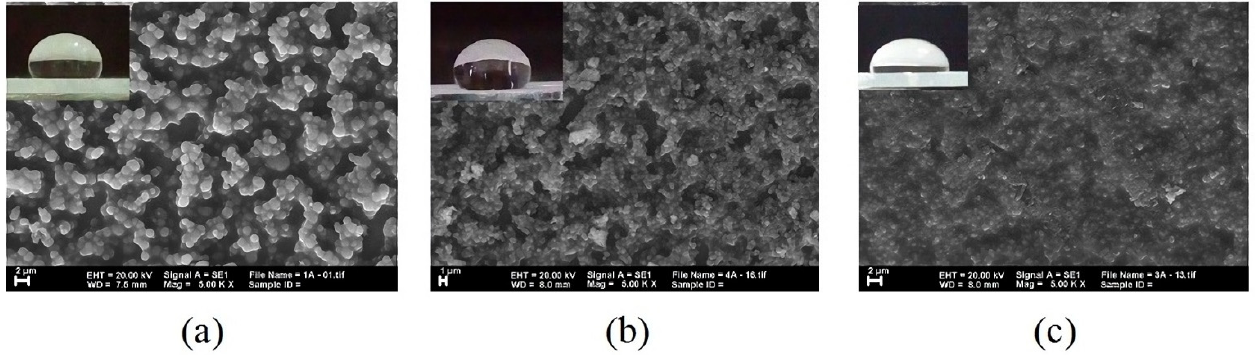
Figure 8. The SEM images of SiO 2 -TiO 2 -OTMS coatings prepared with ( a ) 15, ( b ) 30, and ( c ) 60 mmol of OTMS.